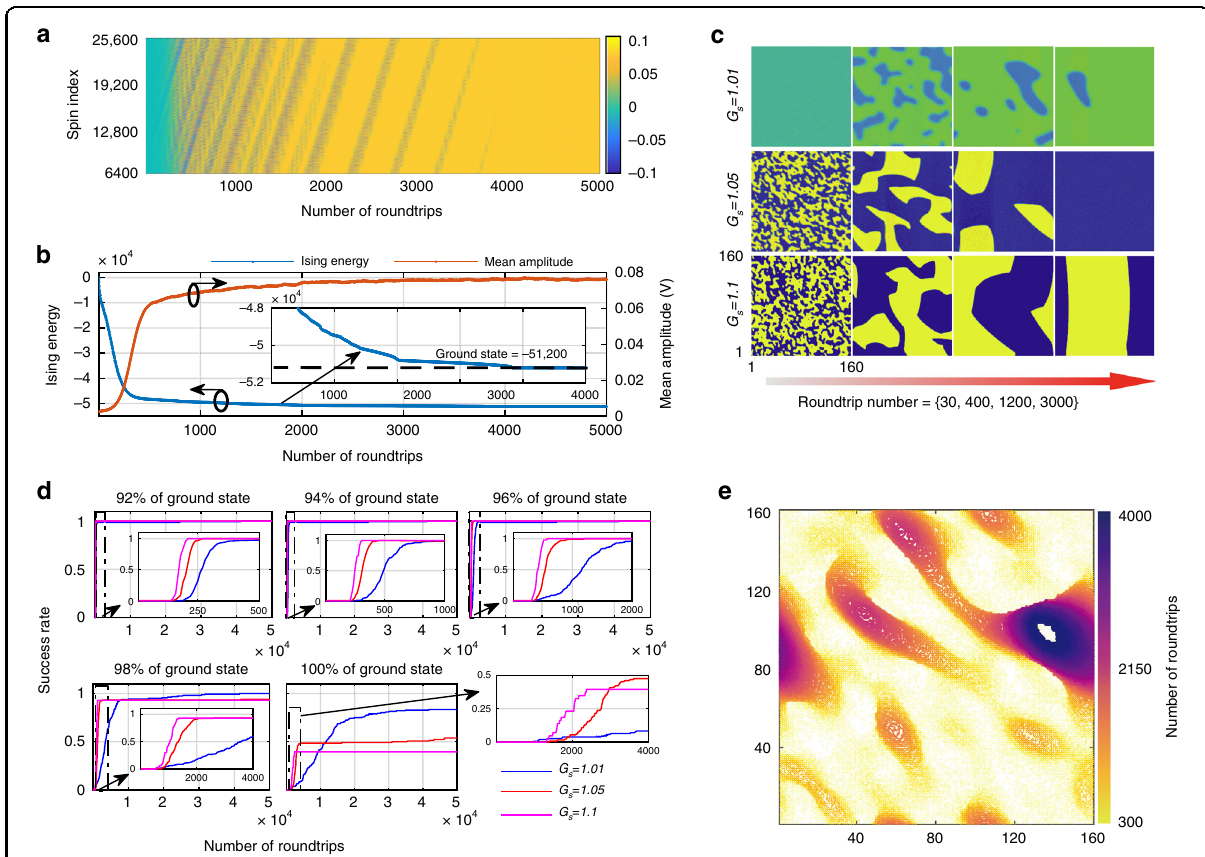
Fig. 4 The experimental results of the 2D Ising machine. a The spin evolution and Ising energy as a function of the number of roundtrips at G s = 1.01. b The Ising energy and the mean amplitude of the spins as functions of the number of roundtrips. c Snapshots of the spin evolution at some speci fi c roundtrips (30, 400, 1200, 3000) at different values of G s = {1.01, 1.05, 1.1}. At the small gains, the domain walls were smooth and small domains evaporated or merged into larger ones, ending up with a whole. At large gains, the domain walls were sharp at the beginning. As the number of roundtrips increased, the machine was trapped in local energy minima associated with parallel domain walls. The Ising machine reached the ground state in the fi rst two cases and froze out in the last cases. d The success rate of cases as a function of the number of roundtrips at which the given percentage of the ground state energy was reached at different small-signal gains. e The superposition of domain walls at different numbers of roundtrips. The domain drift was removed through data processing for a better vision. The evaporation and shrinkage of the domain walls show the dynamics of the machine. The change in color of the contour lines from yellow to purple indicates an increase in the number of round